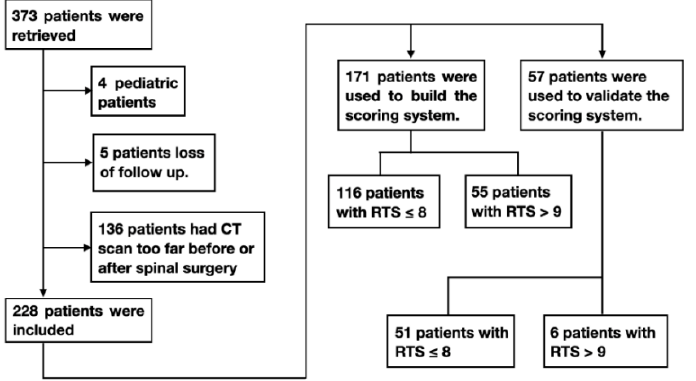
Figure 1. Flow of patient enrollment in this study. Abbreviation: CT = computed tomography; RTS = revised Tokuhashi score.